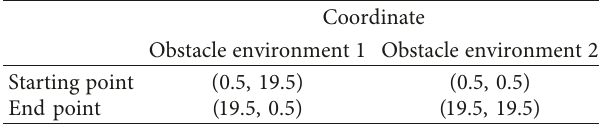
Table 1: Parameters of start and end points of path